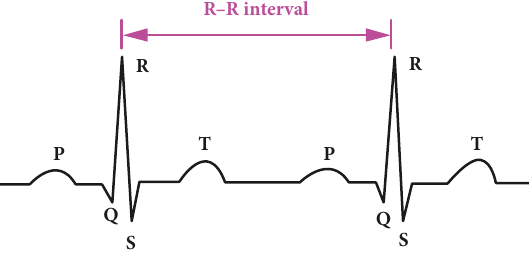
Figure 11: R-R interval of an ECG signal